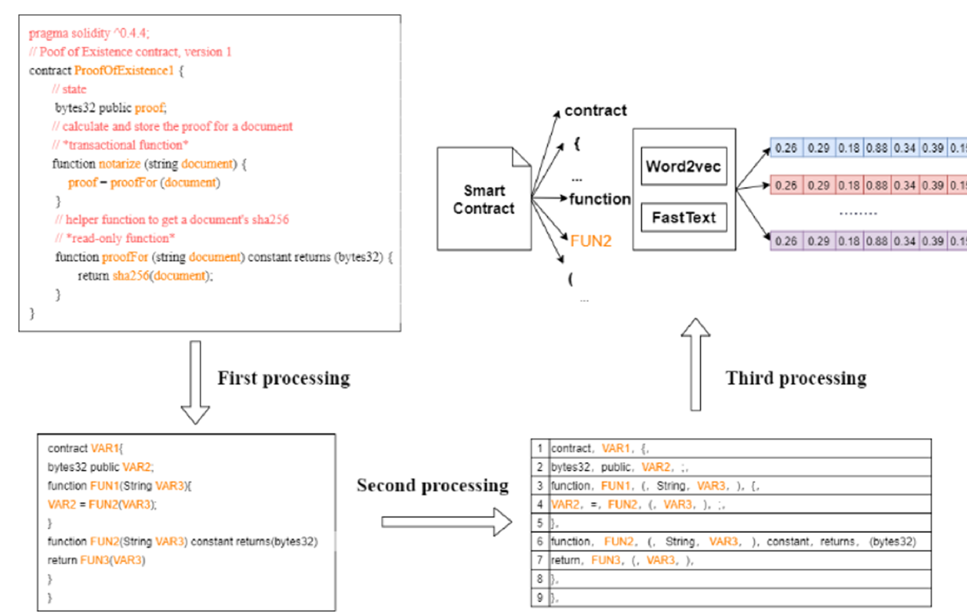
Figure 6. Smart contract word embedding process.